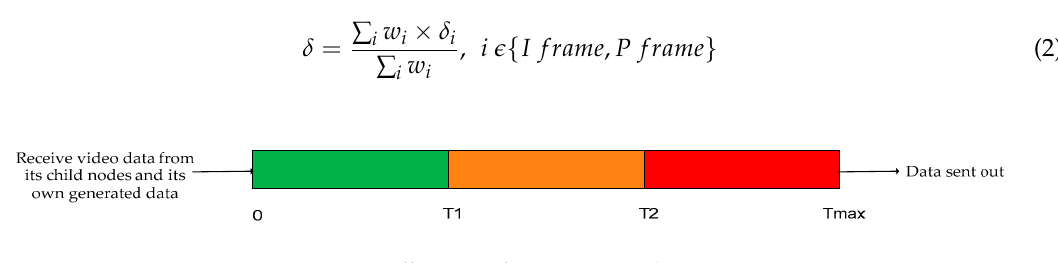
Figure 5. Buffer states for congestion detection.